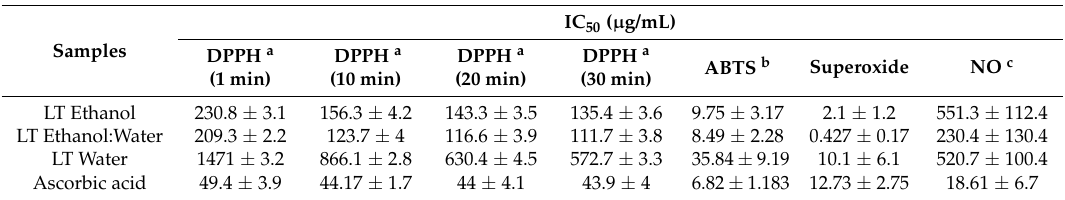
Table 4. Summary data of the assays performed in this study: IC 50 of DPPH, ABTS, Superoxide and NO